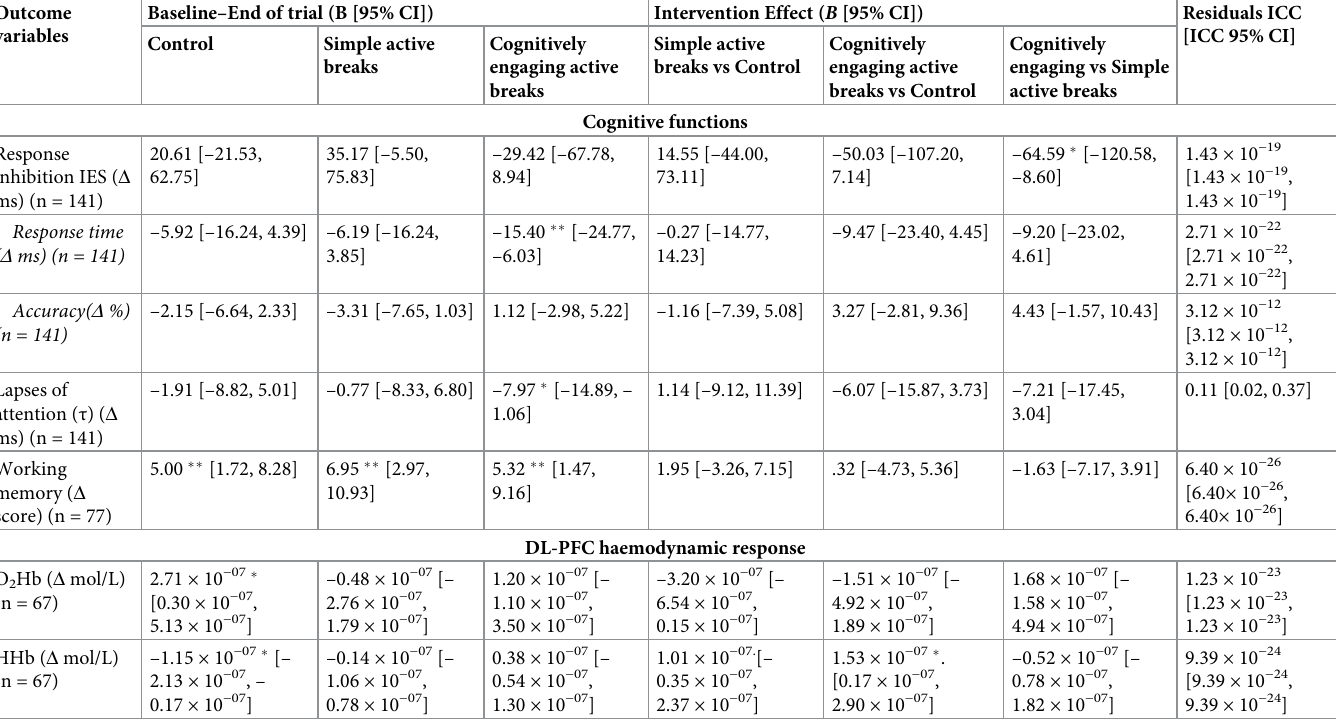
Table 3. Intervention effects for cognitively engaging and simple active breaks compared to usual practice on children’s cognitive functions and DL-PFC haemody- namic response a . Outcome